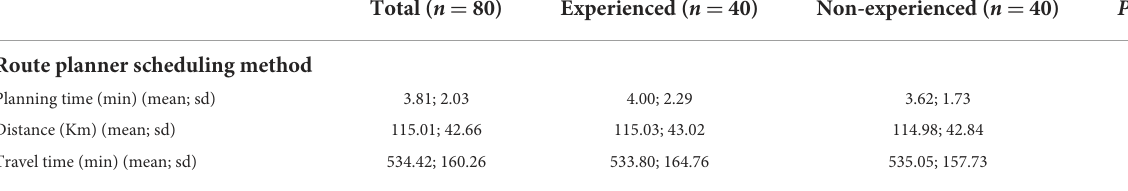
TABLE 7 Route planner scheduling method: comparing groups attending to expertise. Total ( n = 80) Experienced ( n = 40) P ( t test) Route planner scheduling method